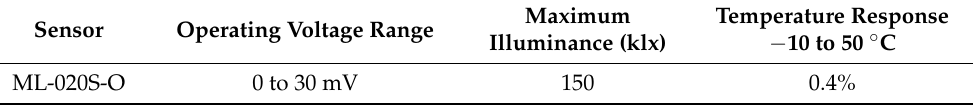
Table 1. Specifications of professional luxometer.